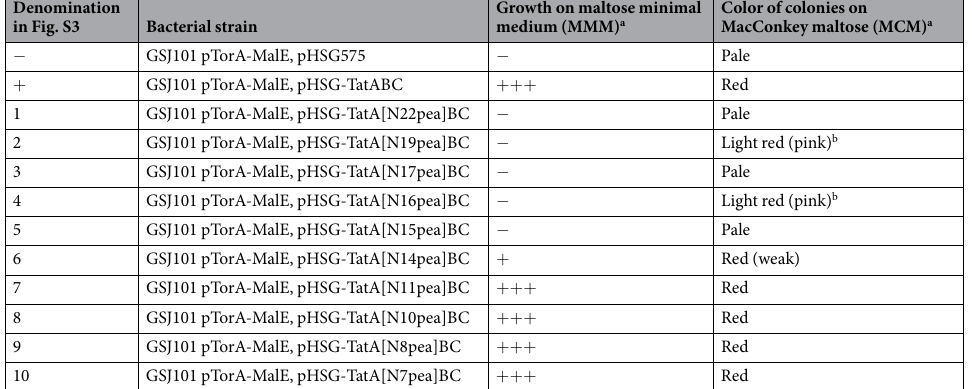
Table 1. Phenotype of bacterial strains on maltose minimal medium and MacConkey maltose. a Bacterial strains were streaked on minimal medium agar plates containing 0.4% maltose as the sole carbon source or on MacConkey agar plates containing 1% maltose and incubated at 37 °C. + + + , fast growth; + , slow growth; − , no growth. b Color presumably due to partial cell lysis (see text for further